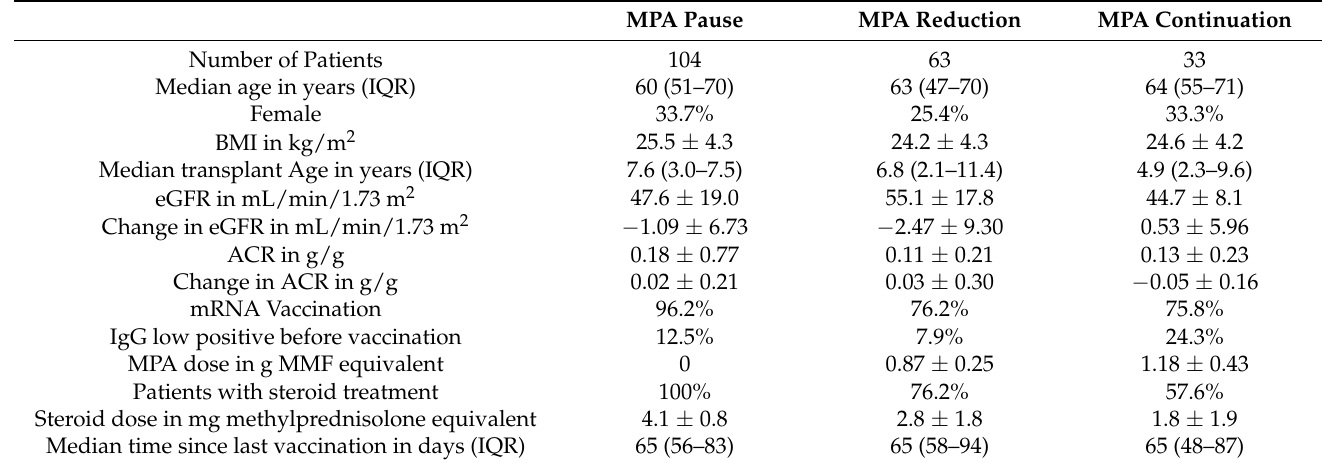
Table 5. Baseline characteristics of patients in the steady MPA group, the reduced MPA group, and the paused MPA group receiving a fourth dose of a SARS-CoV-2 vaccine. Continuous variables are presented as mean ( ± standard deviation) unless stated